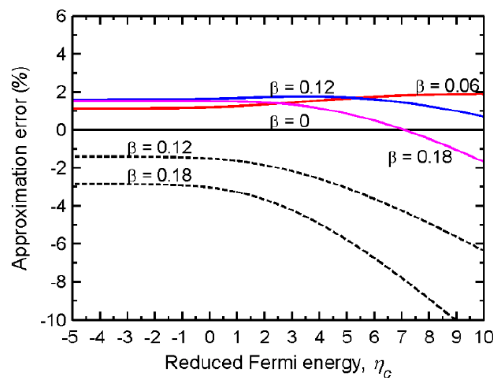
Figure 1. Approximation errors in percentage vs. the reduced Fermi energy (FE) η c as calculated for various values of β . The solid curves display the errors induced by the empirical approximation, and the dashed curves for β = 0.12 and 0.18 by the binomial approximation.